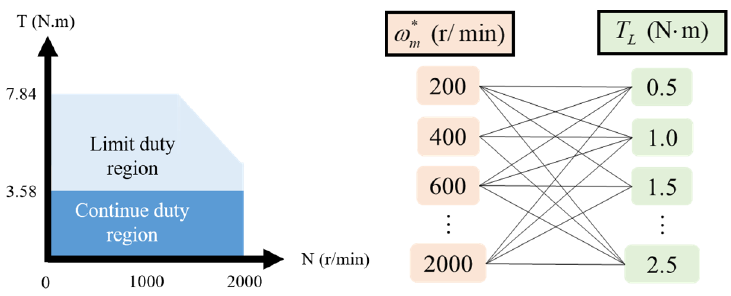
Figure 4. PMSM operation conditions based on the T–N curve.